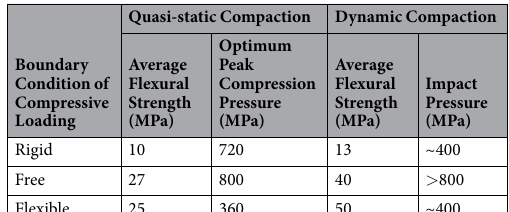
Table 1. Optimum compression pressures and the associated flexural